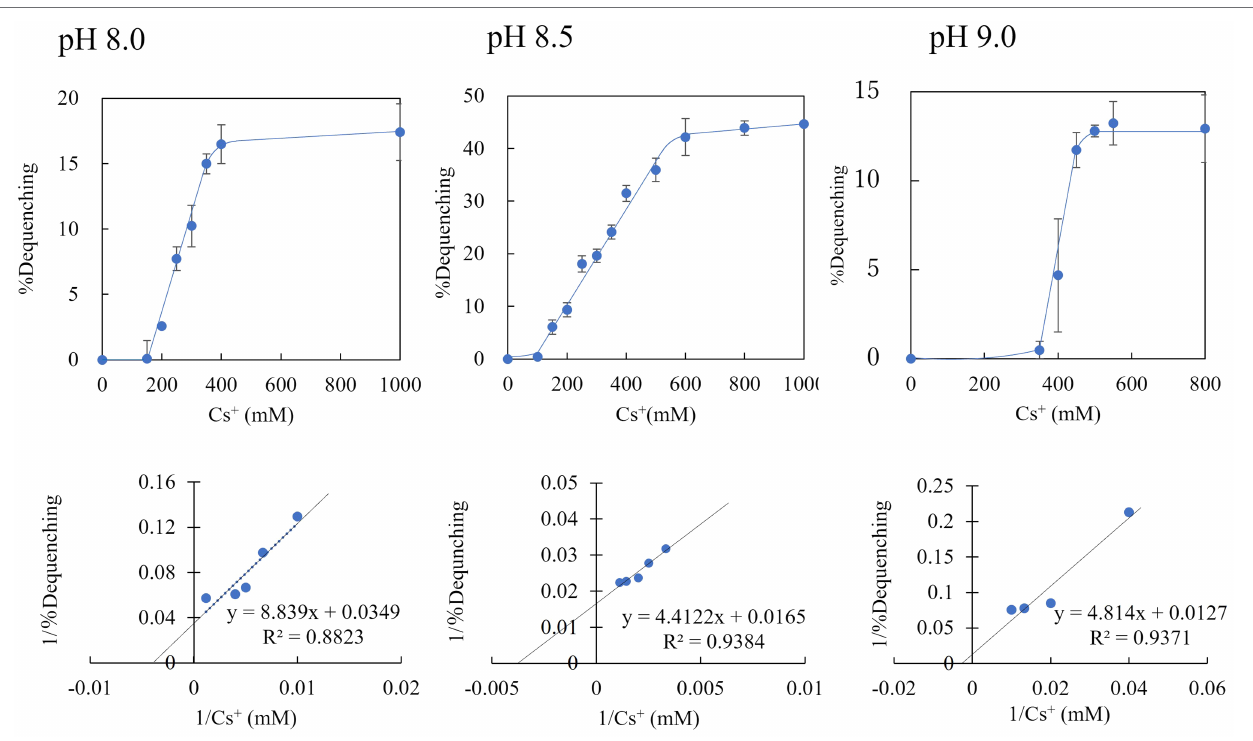
FIGURE 7 | Cs + /H + antiport activity of everted membrane vesicle from strain KNabc/pBAD-00475 at pH 8.0, 8.5, and 9.0. The Cs + /H + antiport activity of everted membrane vesicles from strain KNabc/pBAD-00475 in each pH buffer was shown when various concentrations of Cs 2 SO 4 were added. The details are described in the Materials and Methods section. The vertical axis shows antiport activity (% Dequenching), and the horizontal axis shows the Cs + concentration. Error bars show the standard deviation of three independent experiments. In addition, each Lineweaver-Burk plot diagram is